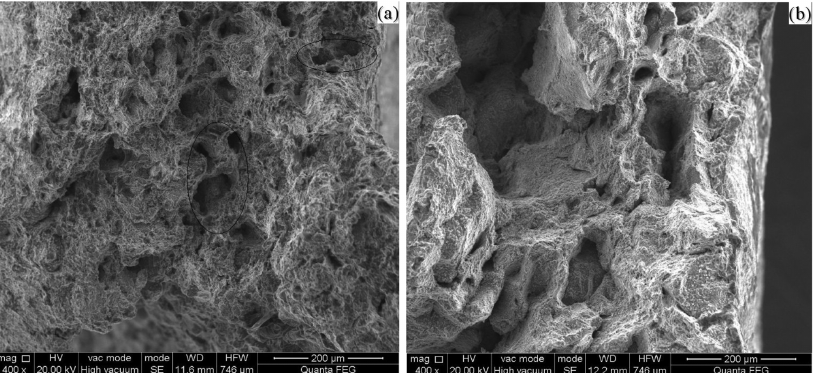
Figure 10: The microscopic fracture appearances: (a) the gathering of dimples for multi-inclined holes specimen and (b) the formation of voids for specimen without holes.